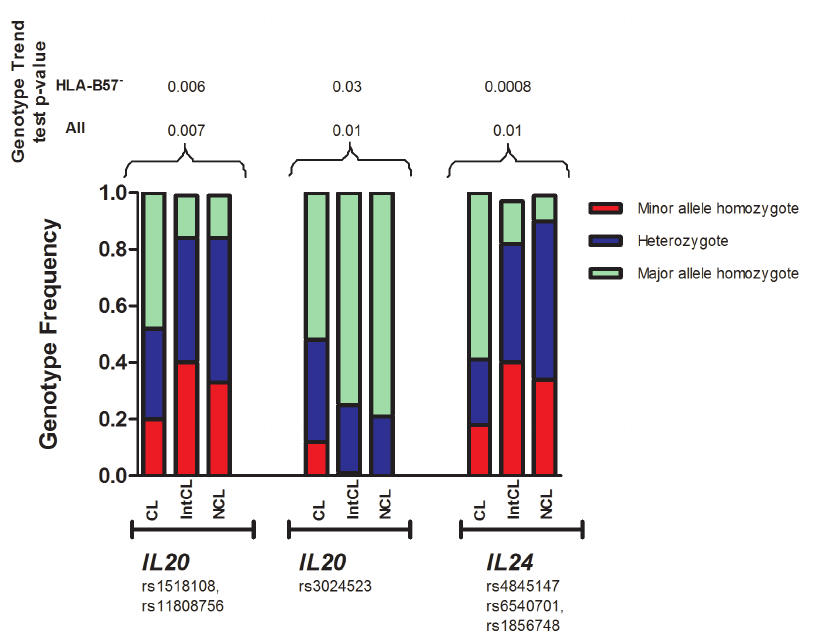
Figure 1. SNPs in IL10 gene family associated with the combined immunological and virological control of HIV infection. Genotype frequencies are compared for all ‘‘controllers’’ (CLs), ‘‘intermediate controllers’’ (IntCL) and ‘‘non-controllers’’ (NCL) as defined by virological and immunological markers. Two SNPs in IL20 (rs1518108 and rs11808752) are in LD ( r 2 =0.90) and data is presented for rs1518108 with more complete data; rs4845147, rs6540701 and rs1856748 in IL24 are in LD ( r 2 =0.91) and data are presented for rs4845147 with more complete data; p-value is presented for all individuals including and excluding 12 HLA-B57 + individuals.